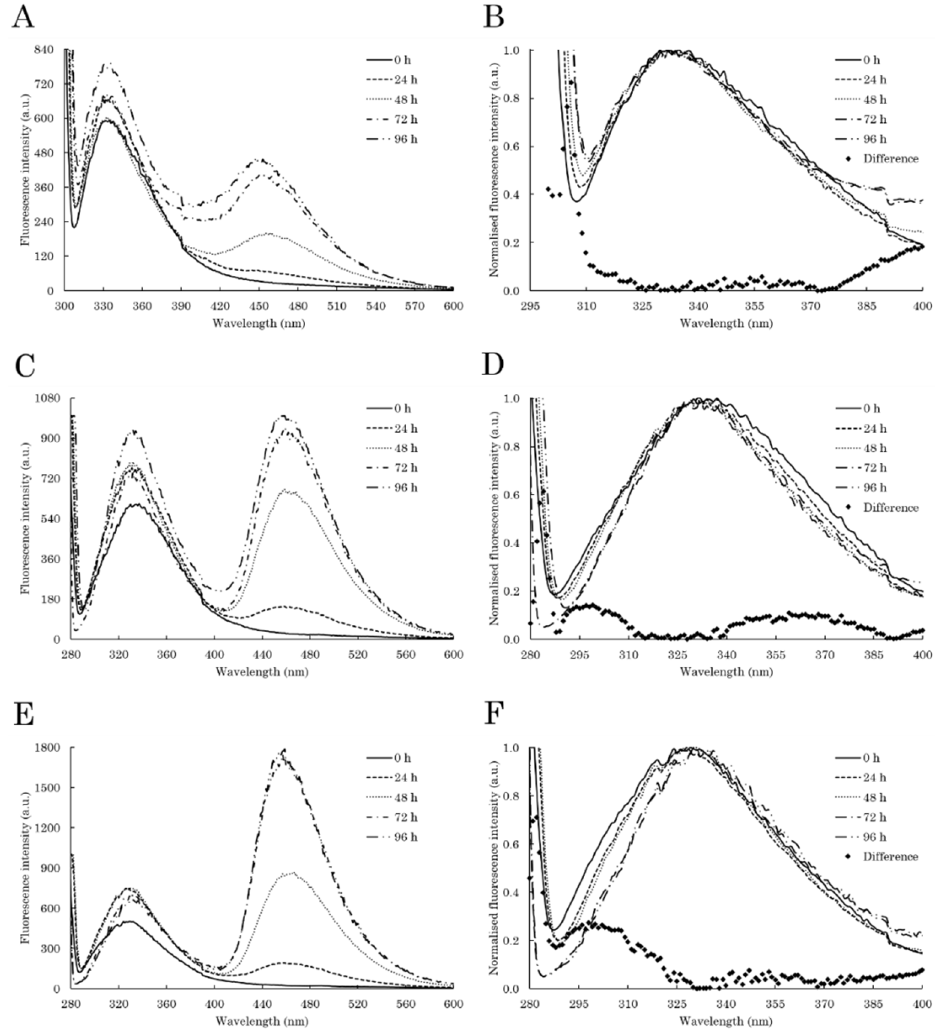
Figure 5. Intrinsic fluorescence spectra of C-TERb ( A – D ) and C-TERa ( E , F ) after 0 h (solid line), 24 h (dashed line), 48 h (dotted line), 72 h (dashed-dotted line), and 96 h (dashed-double-dotted line) of incubation in TBS at ~20 ◦ C (C C-TER = 10 µ M). ( A ) ITF and ( B ) normalised first ITF band spectra ( λ ex = 295 nm, sw = 10 nm). ( C , E ) ITyrF and ( D , F ) normalised first ITyrF band spectra ( λ ex = 275 nm, sw = 10 nm). On each normalised spectrum, the associated difference spectrum is determined between 0 and 96 h (diamonds).